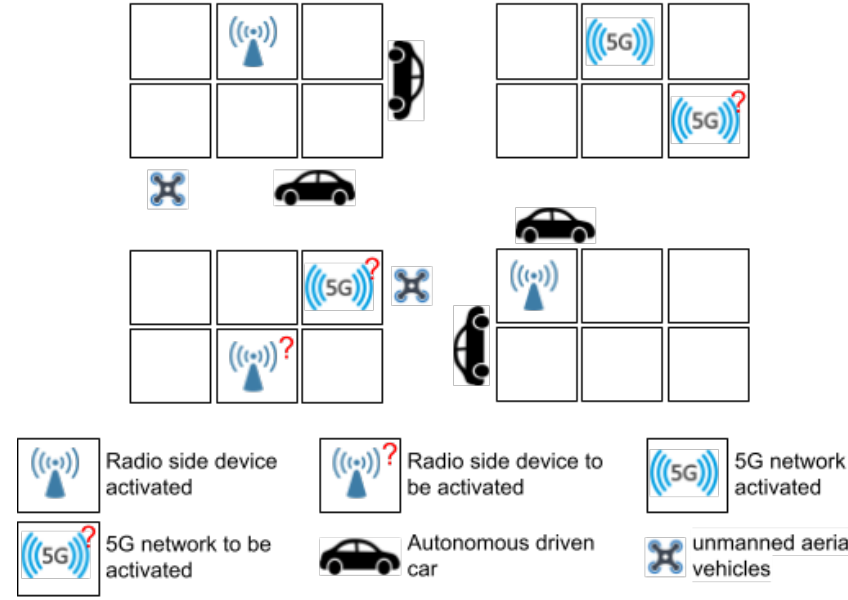
Figure 1. Vehicular networking in a smart